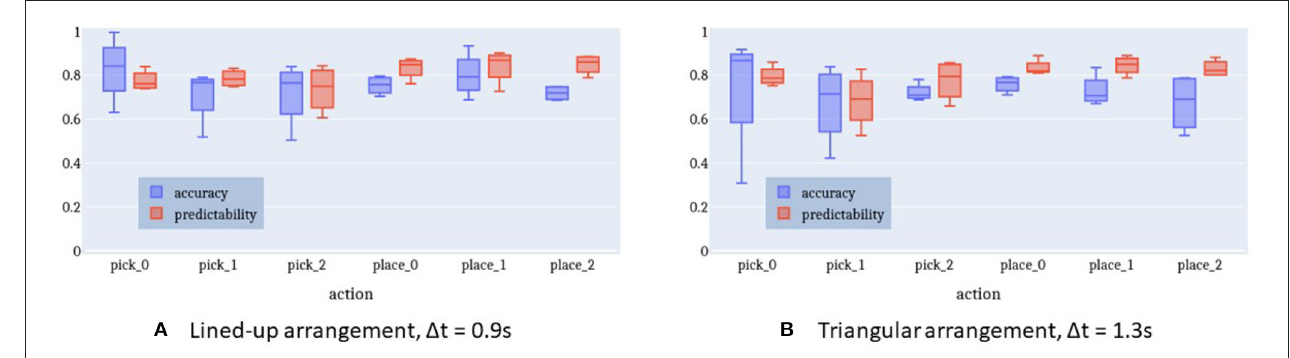
FIGURE 11 | Accuracy and predictability of online intention recognition for lined-up arrangement and triangle shape arrangement. (A) Lined-up arrangement, 1 t = 0.9 s. (B) Triangular arrangement, 1 t = 1.3 s.